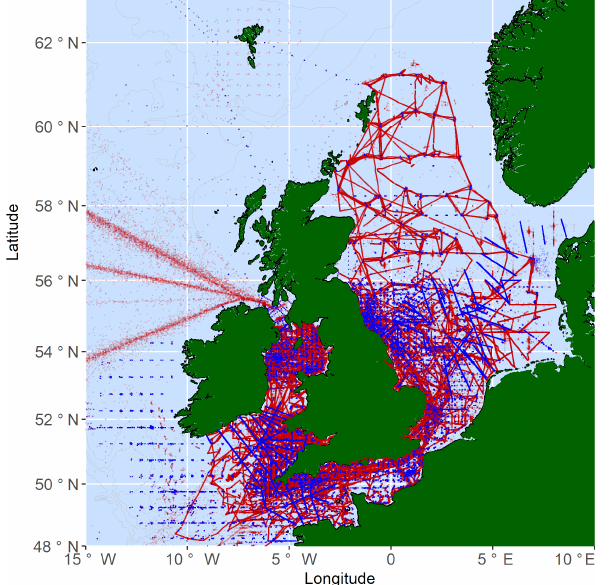
Figure 15. Illustration of the distribution of near-surface data (0– 5m, in red) and mid-water data (20–25m, in blue) for the bulk of the UK Continental Shelf.